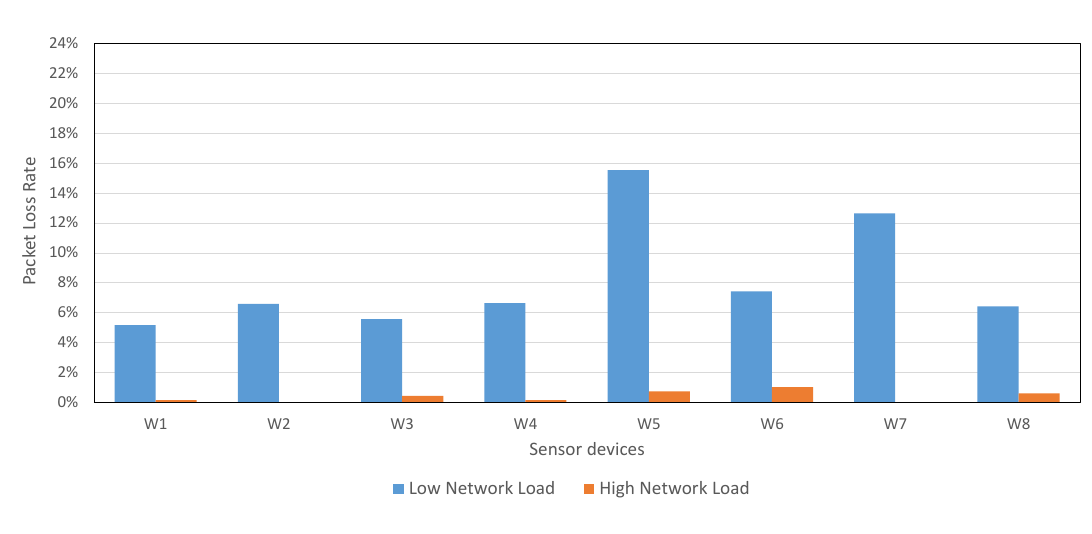
Figure 16. PLR in our mesh proposal for 8 sensor devices with Individual Mesh configuration and 3 CSR devices with saving configuration.